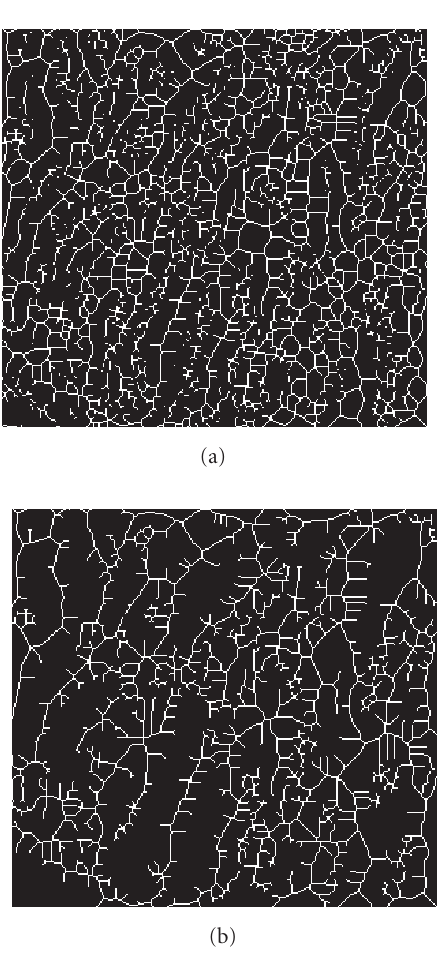
Figure 5.2. Extraction of drainage networks from the original and smoothened DEMs of Great Basin. (a) The drainage network extracted from original DEM. (b) The drainage network extracted from the smoothened